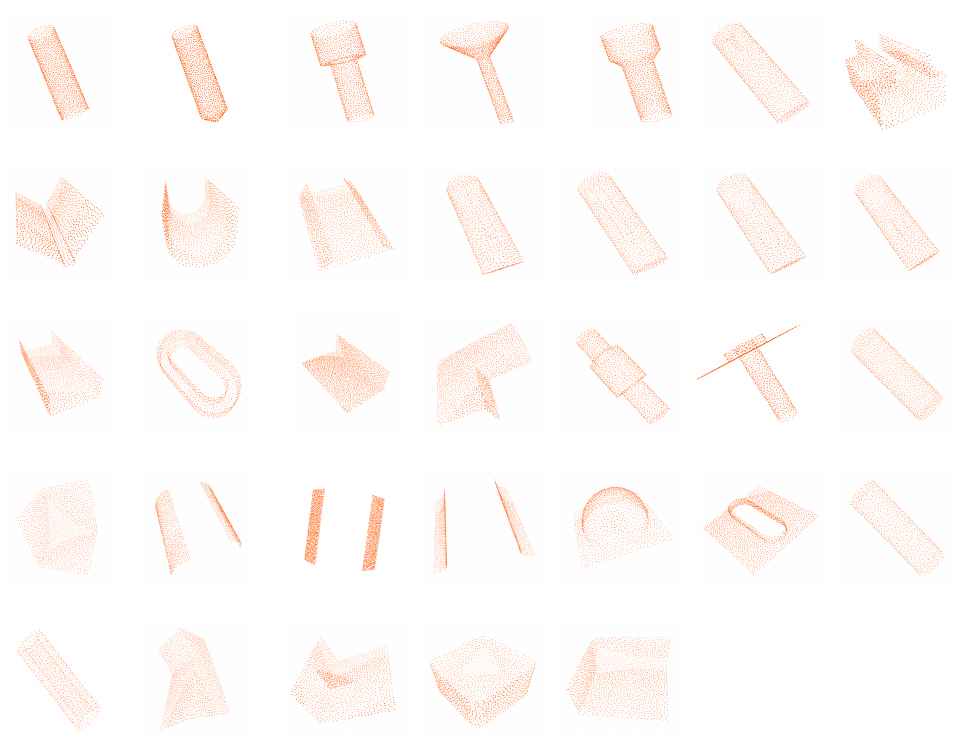
Figure A3. The 512-point sampling models of MFDataset.